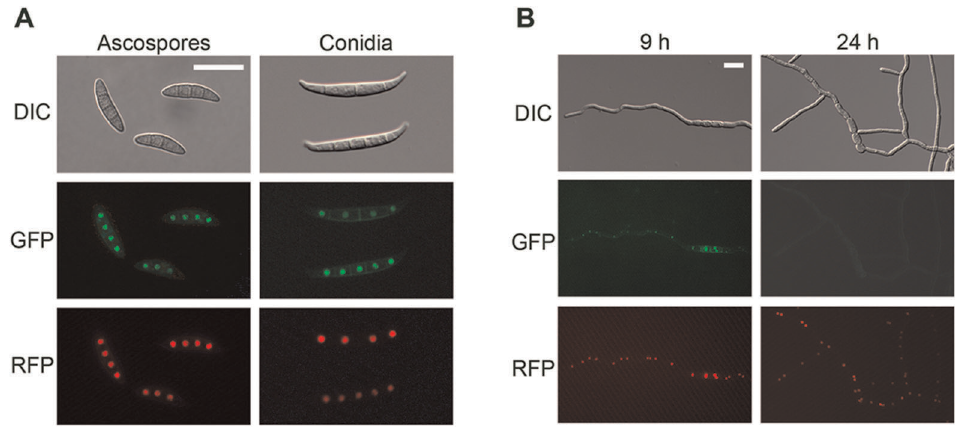
Figure 7. Cellular localization of MYT2. MYT2 was fused with green fluorescent protein (GFP), and histone H1 was fused with red fluorescent protein (RFP). Co-localization of MYT2-GFP and hH1-RFP in spores (A) and germinated conidia 9 and 24 h after inoculation in complete medium (B). DIC, differential interference contrast Scale bar =20 m m.